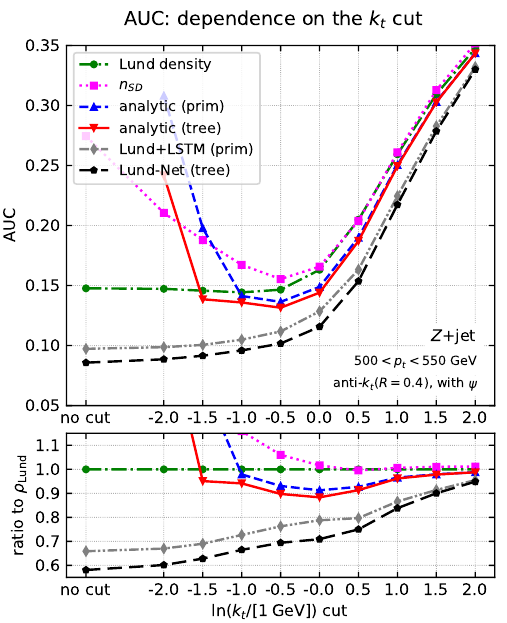
Figure 6. Area under the ROC curve (AUC) obtained using Z +jet events simulated with Pythia. All the Lund-plane based quark-gluon discriminants studied in the paper are shown: the Iterated Soft Drop multiplicity ( n ), the likelihood based on the average primary Lund-plane density, and SD our new analytic and ML-based discriminants using either primary Lund branchings of the full Lund declustering tree. The AUC is plotted as a function of the minimum transverse momentum, k t , cut imposed on the Lund